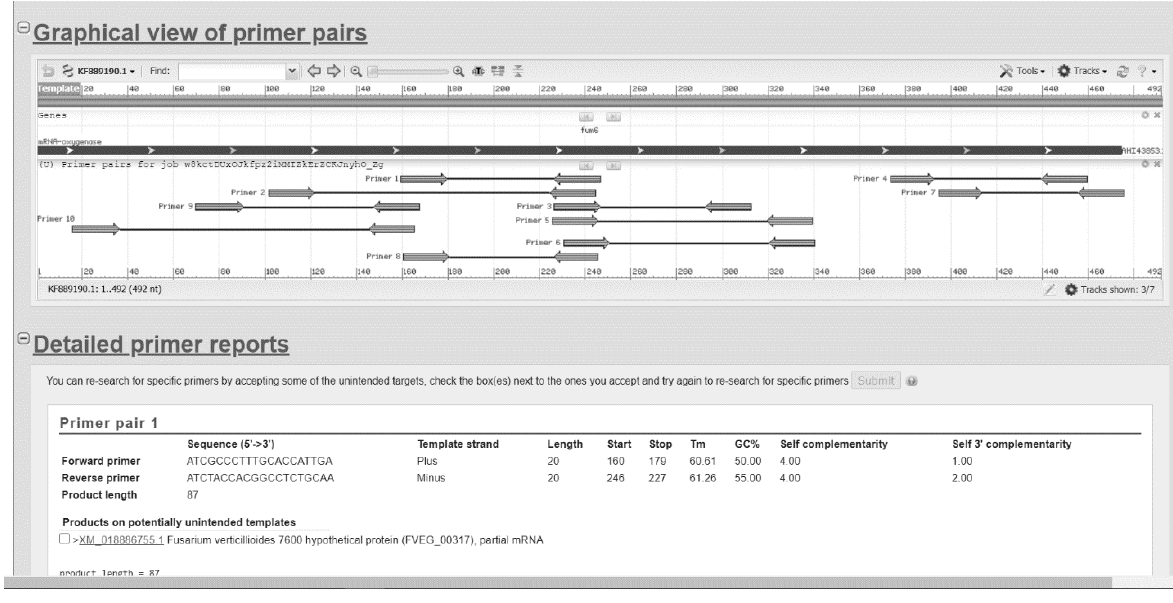
Figure 2. Graphical view of primer pairs and Detailed primer